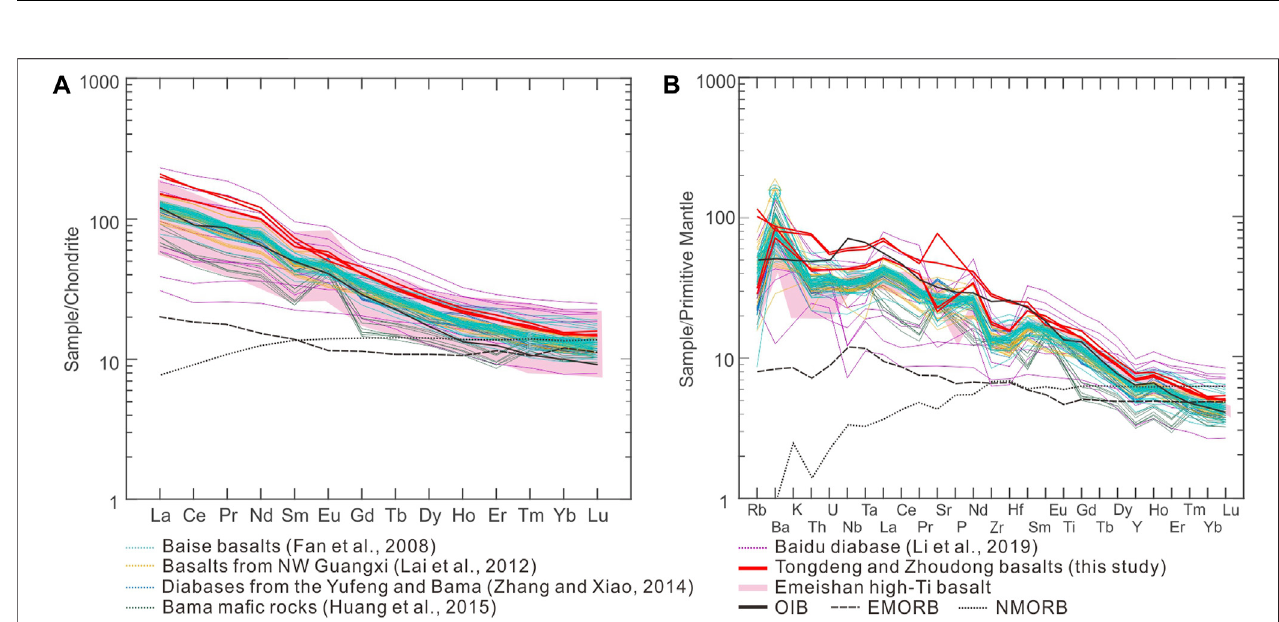
FIGURE6|(A) Chondrite-normalized REEand (B) primitivemantlenormalizedmulti-elementspidergramforthema fi crocksinwesternGuangxi(normalizingvalue after Sun and McDonough, 1989).